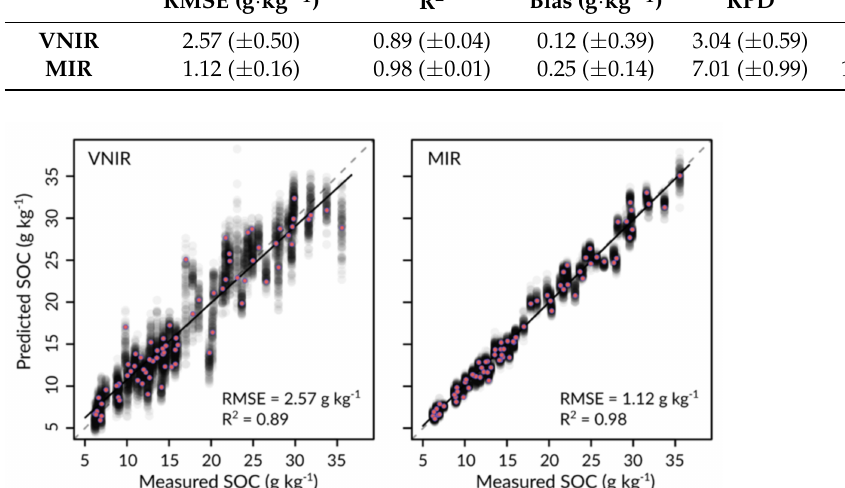
Figure 4. Pooled validation results of VNIR and MIR SOC estimates for the ‘best-case’ scenario with averaged spectral data from all measurement series (VNIR AVG and MIR AVG ) and averaged SOC reference data from all three laboratories. Red points correspond to the runs with average RMSE values to illustrate typical errors of VNIR- or MIR-predicted SOC values. Transparent gray points represent predictions from all 100 cross-validation runs, indicating the predictive uncertainty associated with each data point.